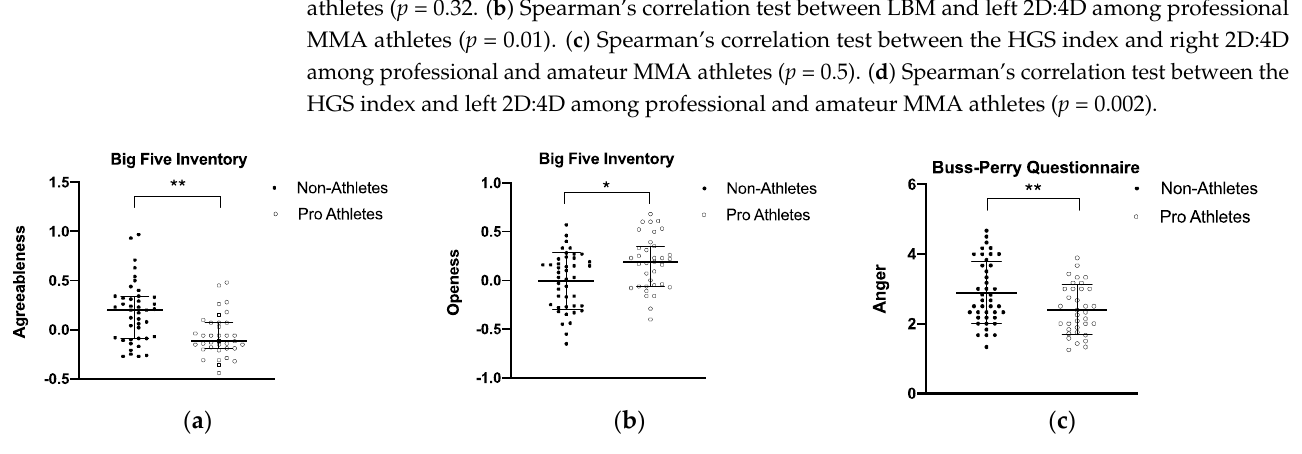
Figure 4. ( a ) Median and interquartile ranges for BFI agreeableness between groups of professional athletes (n = 35) and non-athletes (n = 42). ( b ) Mean and standard error for BFI openness between groups of professional athletes (n = 35) and non-athletes (n = 42). ( c ) Mean and standard error for BPQ anger between groups of professional athletes (n = 35) and non-athletes (n = 42). * p > 0.05 ** p >